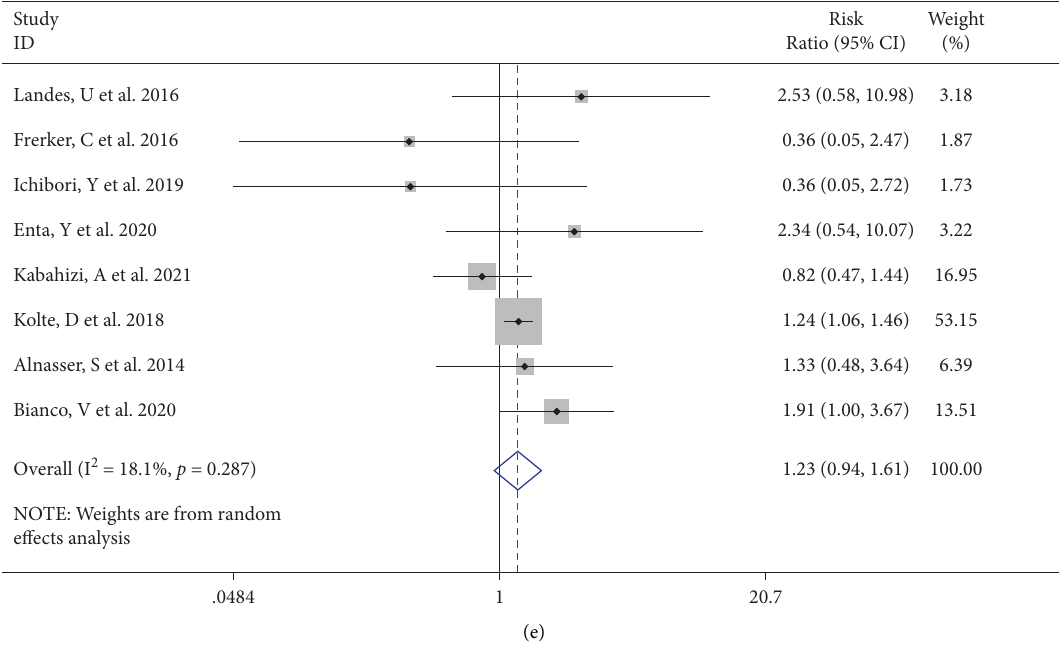
Figure 6: Forest plot showing there was no significant difference in vascular complications (a), major vascular complications (b), PPM placement (c), cerebrovascular events (d), and moderate to severe PVL (e) between the emergent TAVI group and elective TAVI group. CI, confidence